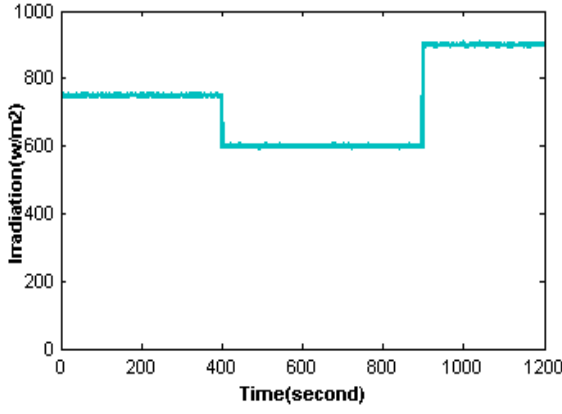
Figure 5. Irradiation received by module.